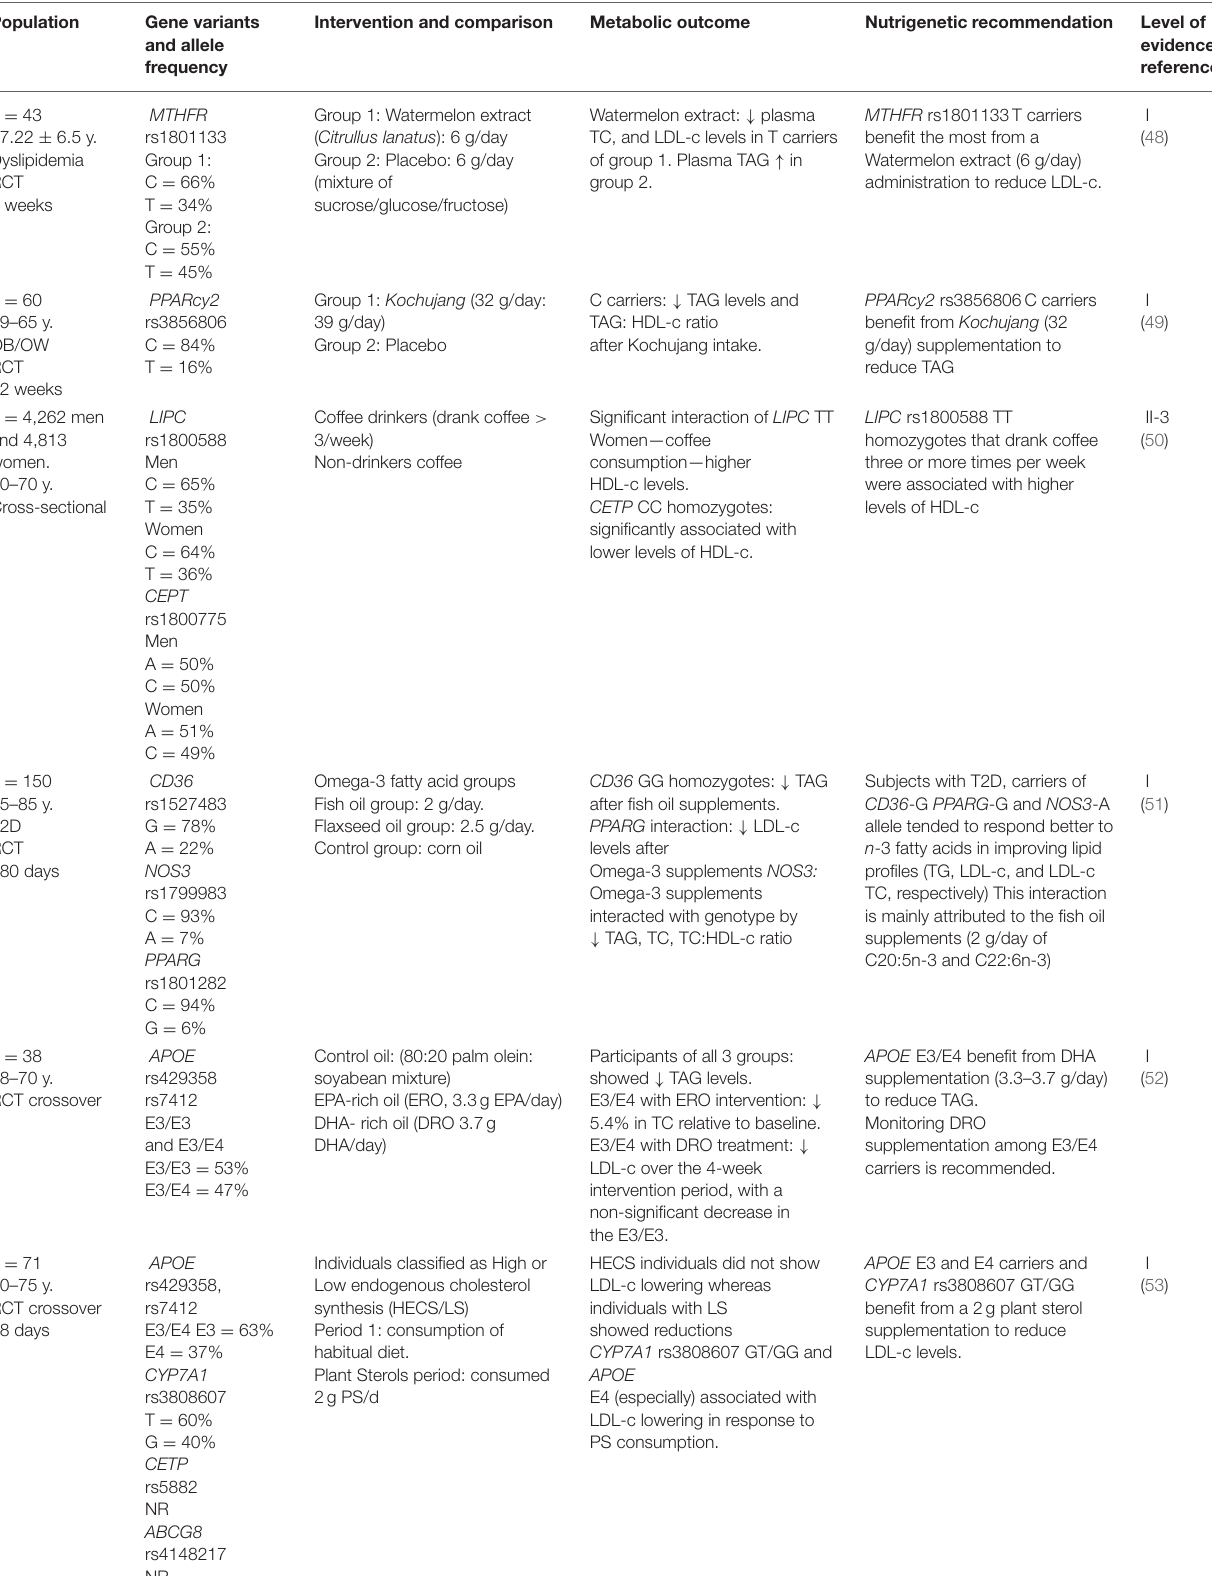
TABLE 3 | Gene variants and nutraceutical or dietary